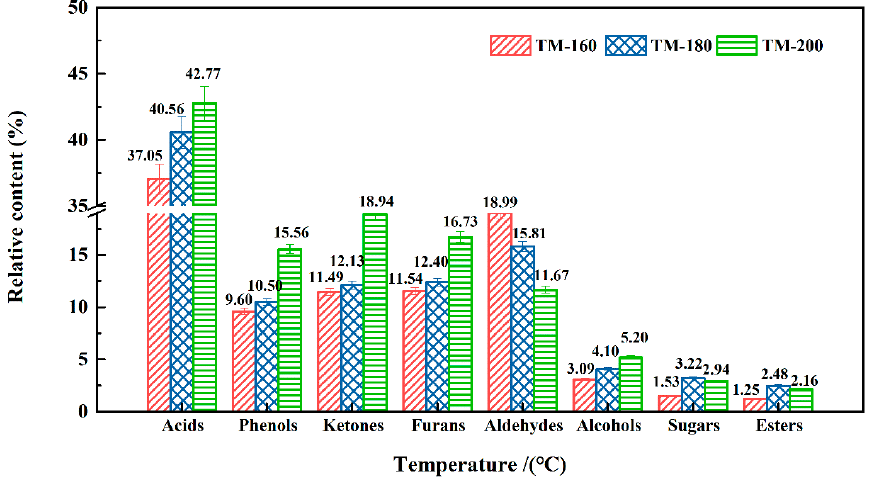
Figure 12. The relative contents of components in VOCs released from different thermal modification temperatures.